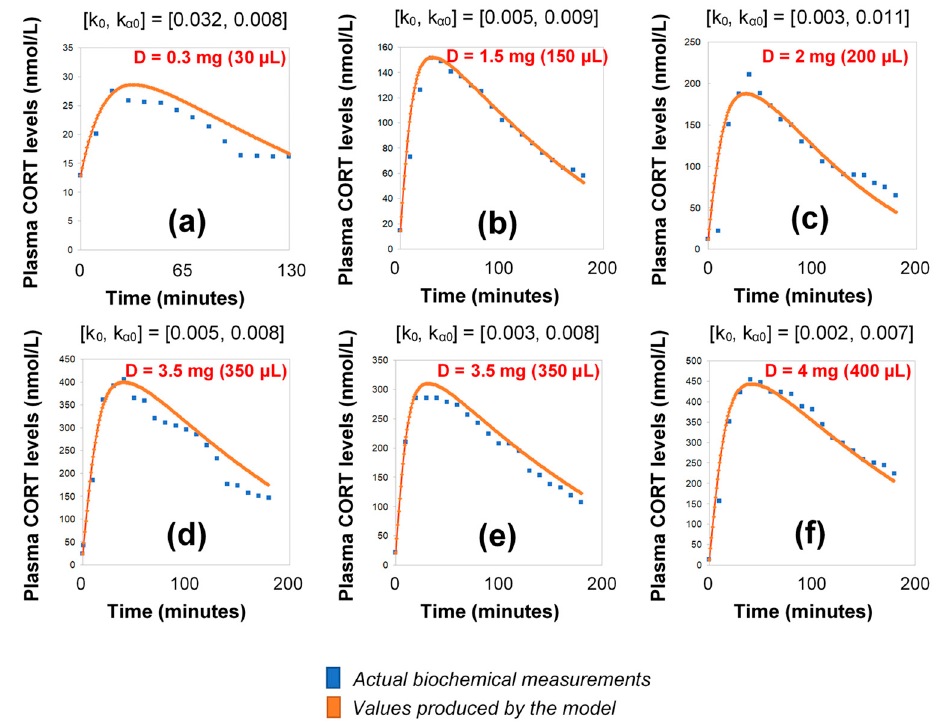
Figure 3. Simulation of plasma cortisol changes in different healthy subjects with pharmacologically suppressed cortisol biosynthesis with dexamethasone (see Materials and Methods) after the subcutaneous infusion of varying doses of hydrocortisone. The simulations were produced by the revised model (see Materials and Methods), which assumes discretely varying absorption and secretion rates of cortisol. ( a ) female subject, BMI: 20.4, pulse time: 10:00 a.m., pulse volume (D): 30 µ L (0.3 mg); ( b ) male subject, BMI: 30, pulse time: 10:00 a.m., pulse volume (D): 150 µ L (1.5 mg); ( c ) male subject, BMI: 22.5, pulse time: 10:30 a.m., pulse volume (D): 200 µ L (2 mg); ( d ) male subject, BMI: 21.2, pulse time: 09:50 a.m., pulse volume (D): 350 µ L (3.5 mg), ( e ) male subject, BMI: 23.3, pulse time: 10:10 a.m., pulse volume (D): 350 µ L (3.5 mg); ( f ) female subject, BMI: 23.4, pulse time: 09:50 a.m., pulse volume (D): 400 µ L (4 mg); BMI: body-mass index, CORT: cortisol,